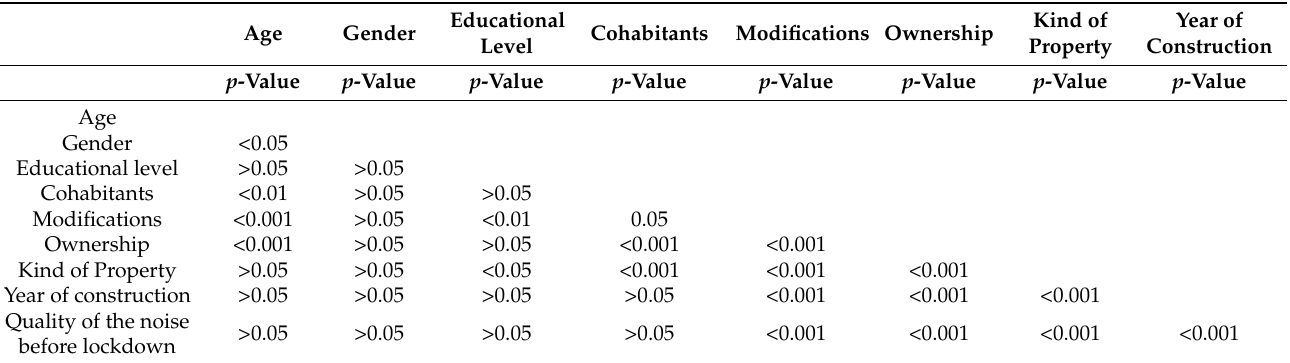
Table 1. Correlations of the sociodemographic data.